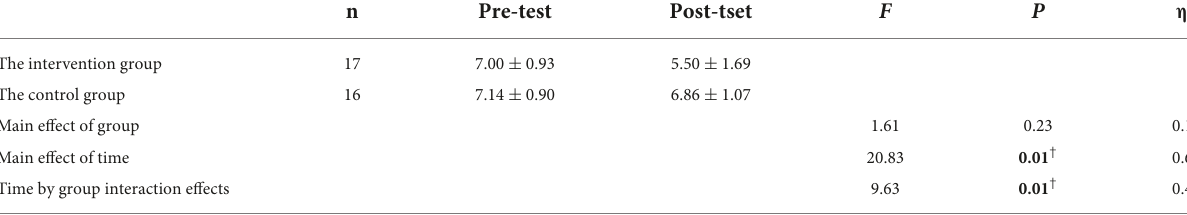
TABLE 2 Results of the analysis of the VAS of the two groups of patients in the pre-test and post-test.